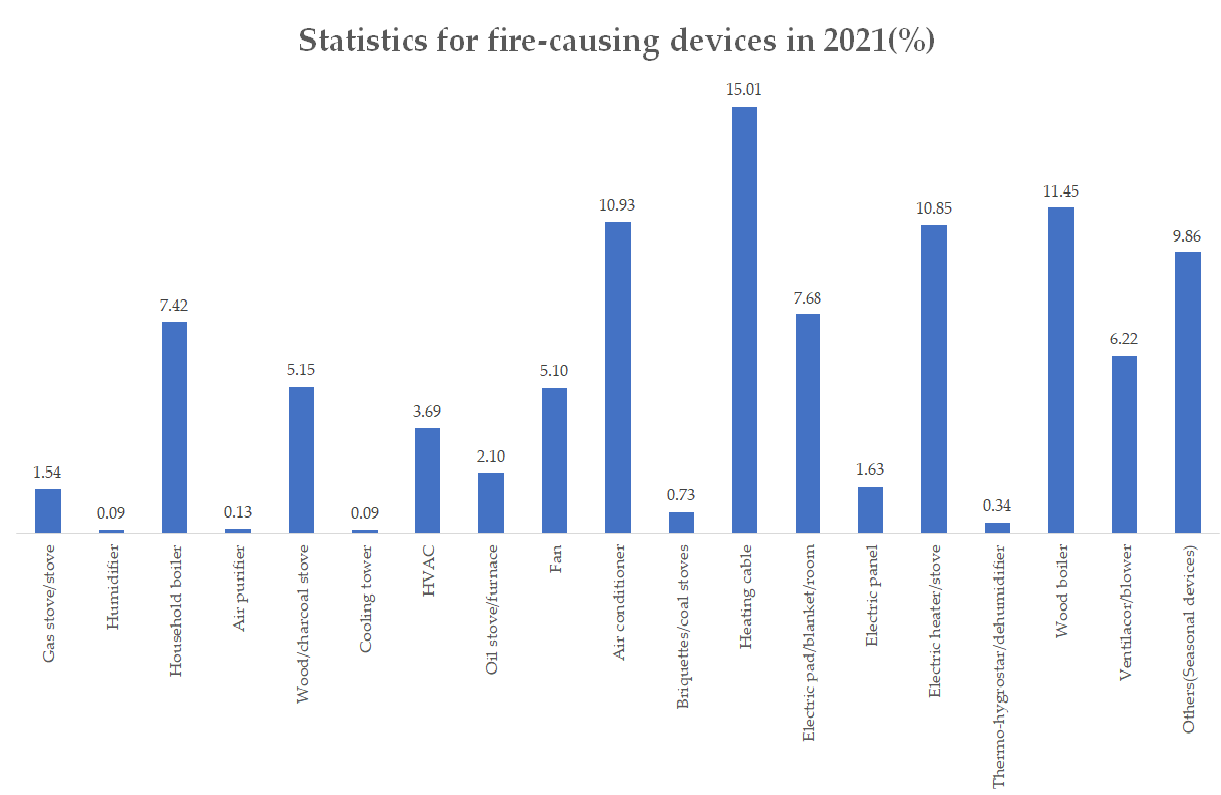
Figure 1. Statistics of fire-causing devices reported to National Fire Information Center.